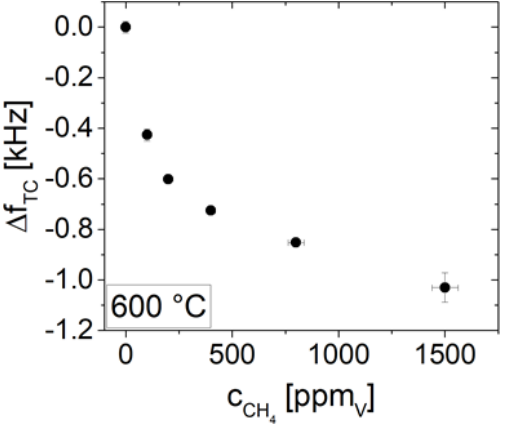
Figure 16. Temperature-compensated resonance frequency shift in dependence of methane concentration for a 5MHz resonator coated with a SnO 2